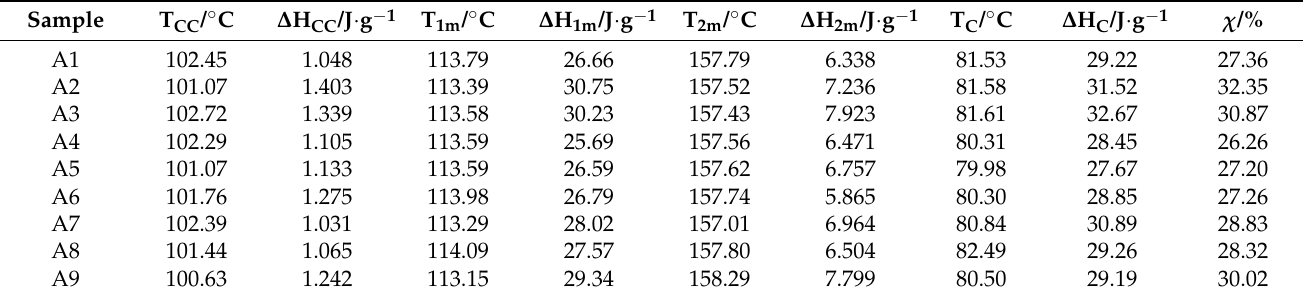
Figure 7. DSC analysis of different PLA/PBS composites: ( a ) melting curves and ( b ) crystallization curves. Table 3. DSC characteristic parameters of different